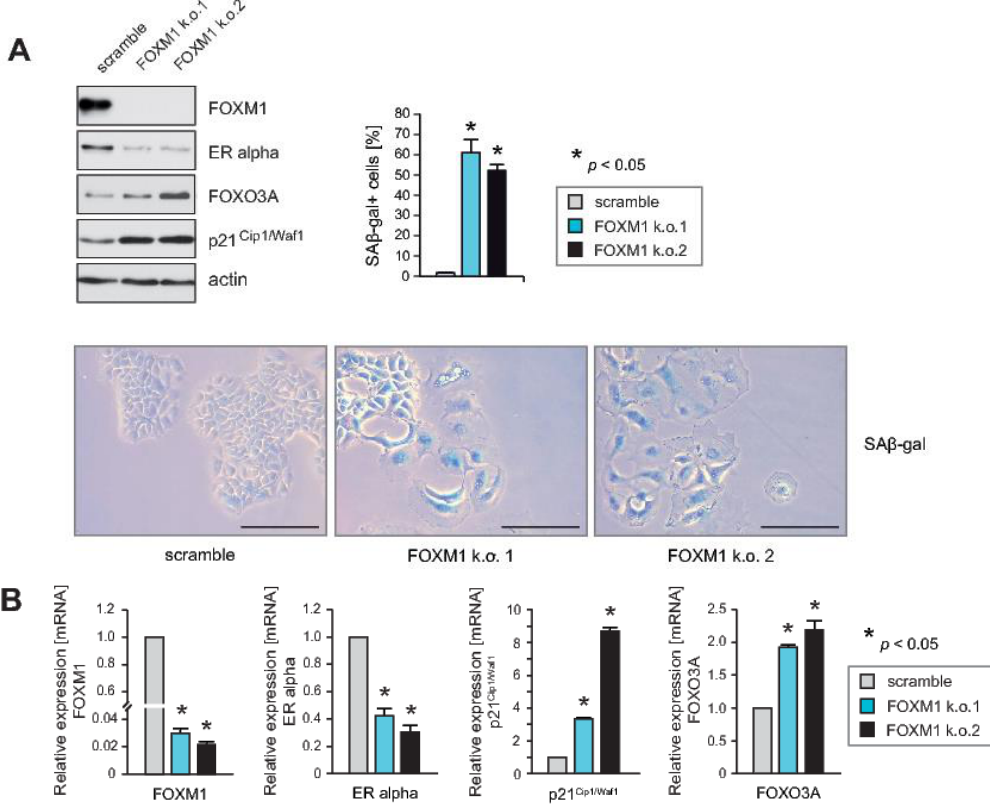
Figure 2. Knockdown of FOXM1 inhibits expression of ER α and induces cell cycle arrest and senescence, phenocopying the e ff ects of RASSF1A. ( A ) Stable knockdown of FOXM1 was performed in parental MCF7 cells using shRNAs (FOXM1k.o.1 and FOXM1k.o.2). Cell extracts were prepared 48 h after lentiviral transduction. Western blots of lysates from the two independent FOXM1 shRNAs (FOXM1k.o.1 and FOXM1k.o.2) in MCF7 cells were probed with the indicated antibodies. Actin served as a loading control (upper left panel). Knockdown of FOXM1 using FOXM1k.o.1 and FOXM1k.o.2 in MCF7 cells induced growth inhibition and senescence as evidenced by SA β -gal staining 48 h after lentiviral transduction (lower panel). Bars = 100 µ m. Quantification of the percentage of SA β -gal positive cells in two independent knockdowns of FOXM1 expression in MCF7 cells (FOXM1k.o.1 and FOXM1k.o.2) is presented as mean values ± s.d. of three independent experiments. p -values < 0.05 are indicated by asterisks (upper right panel). ( B ) Knockdown of FOXM1 in MCF7 cells using the shRNAs FOXM1k.o.1 and FOXM1k.o.2 was performed and mRNA was prepared 48 h after lentiviral transduction. Transcript levels of the indicated genes were analyzed by quantitative PCR. Mean values ± s.d. of three independent experiments are presented. p -values < 0.05 are indicated by